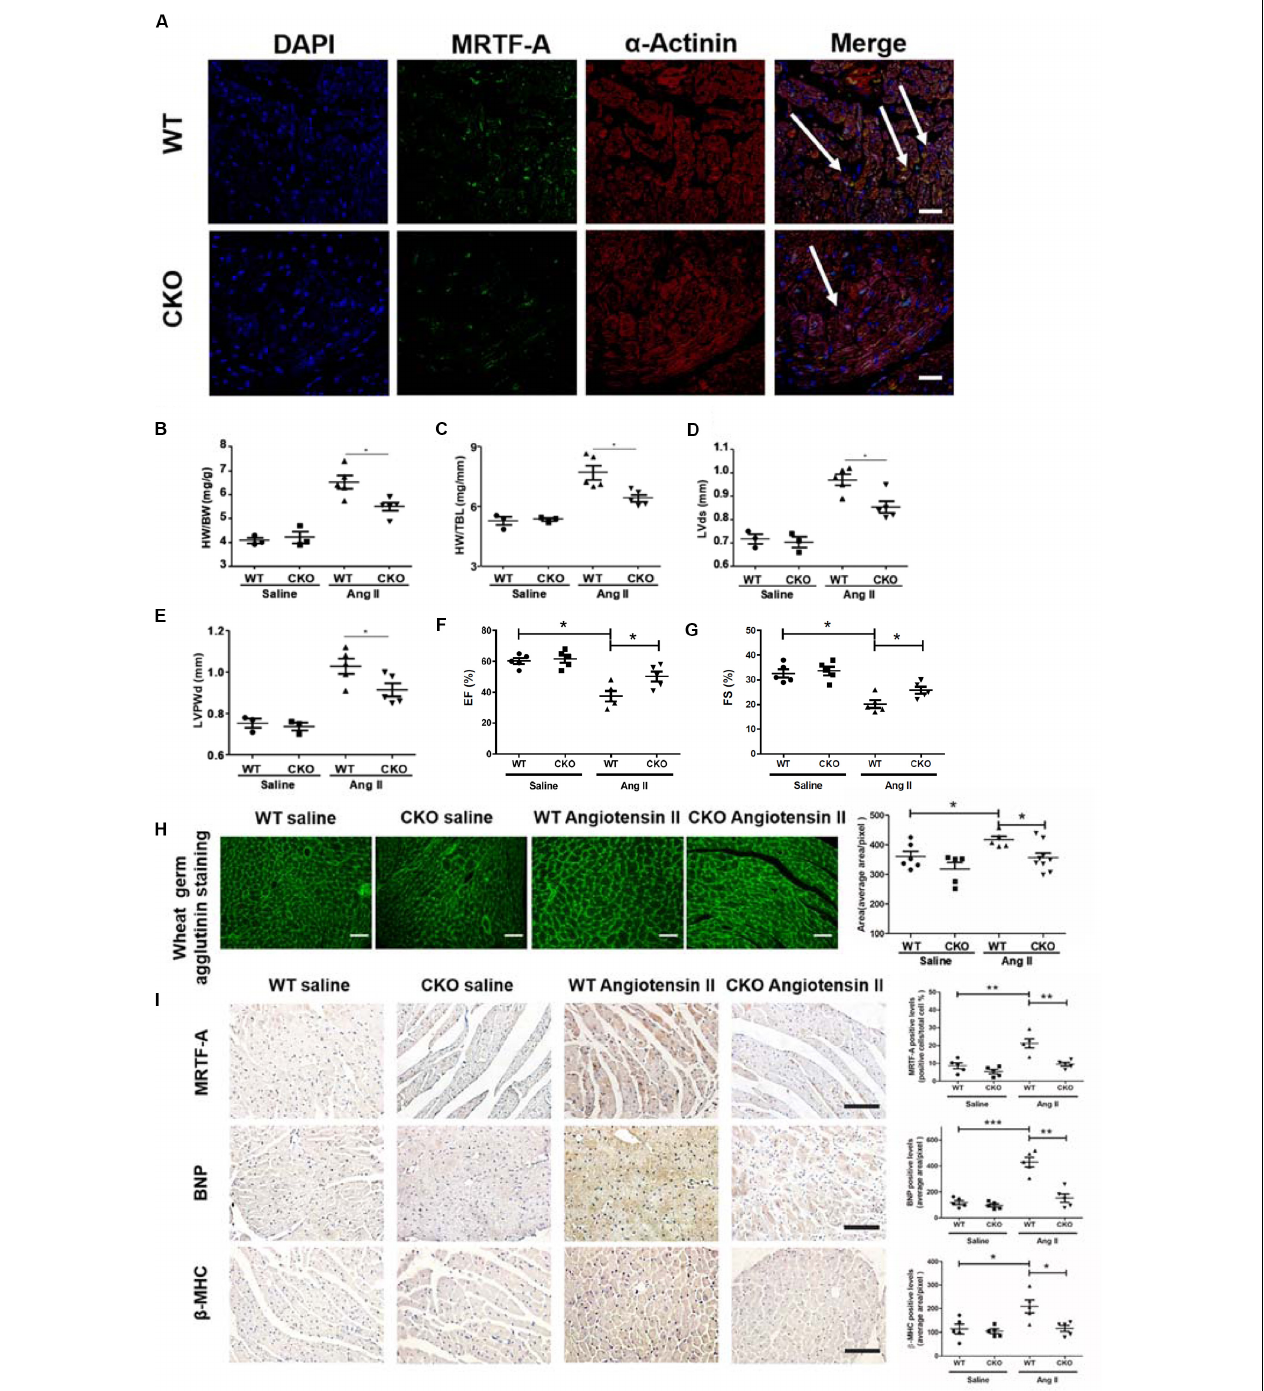
FIGURE 1 | Cardiomyocyte deletion of myocardin-related transcription factor A (MRTF-A) attenuates Ang-II-induced cardiac hypertrophy in mice. MRTF-A conditional knockout (CKO) mice and wild-type (WT) mice were induced to develop cardiac hypertrophy by Ang II infusion as described in section “Materials and Methods.” (A) Immunofluorescence staining was performed with anti-MRTF-A and anti-actinin. (B) Heart weight vs. body weight ratio. (C) Heart weight vs. tibia bone length ratio. (D) Echocardiographic measurements of left ventricular systolic dimension (LVSd). (E) Echocardiographic measurements of left ventricular posterior wall dimension (LVPWd). (F) Echocardiographic measurements of ejection fraction (EF). (G) Echocardiographic measurements of fractional shortening (FS). (H) Cardiac sections were stained with wheat germ agglutinin (WGA). Cross-sectional areas were quantified by Image Pro. (I) Immunohistochemistry (IHC) staining of cardiac sections with anti-MRTF-A, antibrain natriuretic peptide (anti-BNP), and anti- β -major histocompatibility complex (anti- β -MHC) antibodies, Cross-sectional areas were quantified by Image Pro. N = 3–5 mice for the saline groups and N = 5 mice for the Ang II groups. Error bars represent SD. * p < 0.05; ** p < 0.01; *** p < 0.001. Scale bar: 50 µ